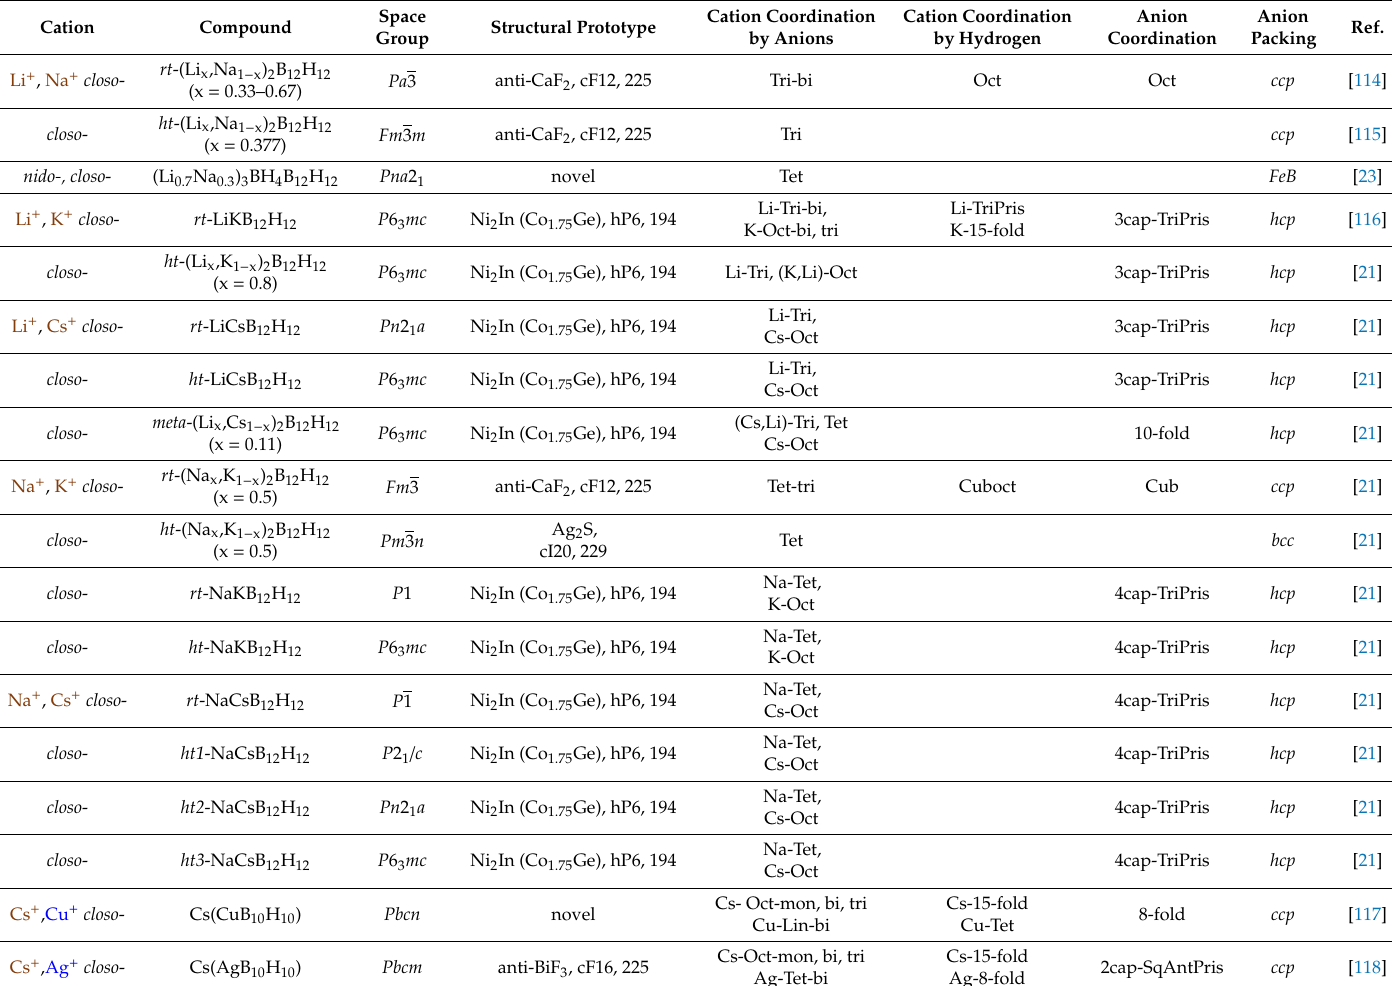
Color coding: alkali metals: brown; transition elements: